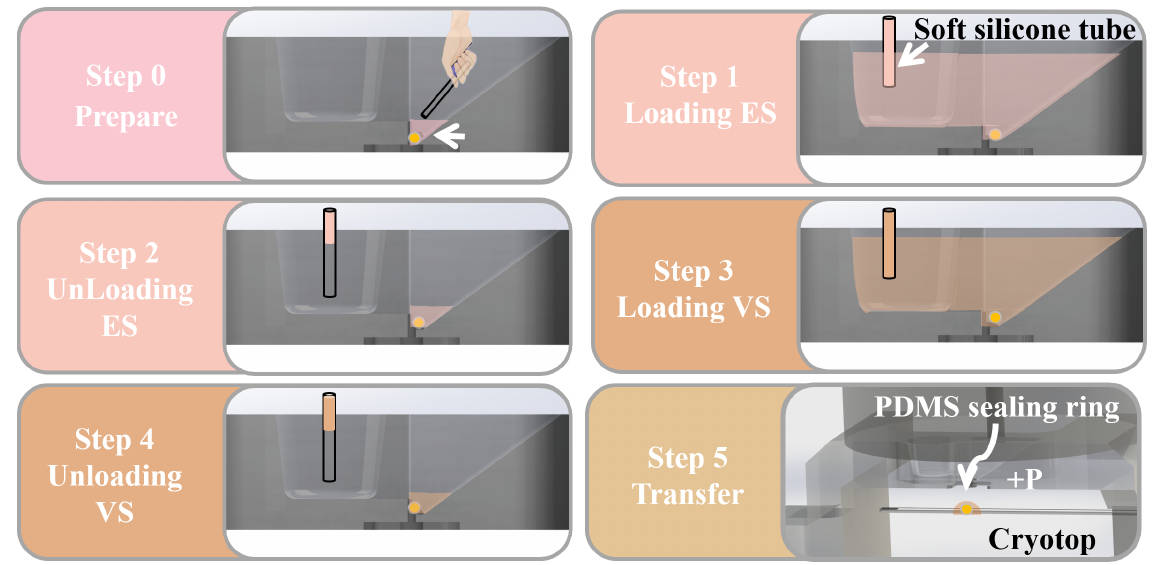
Figure 4. The operation steps of vitrification on the open microfluidic chip: preparation, loading and unloading ES/VS and